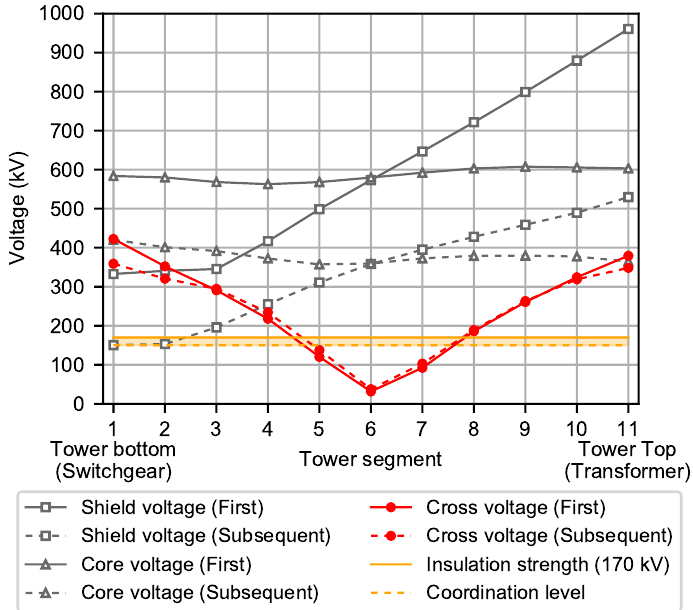
Figure 7. Overvoltage distribution across the power cable with downward lightning: 60 kA and 4/75 µ s (first stroke), and 20 kA and 1/75 µ s (subsequent